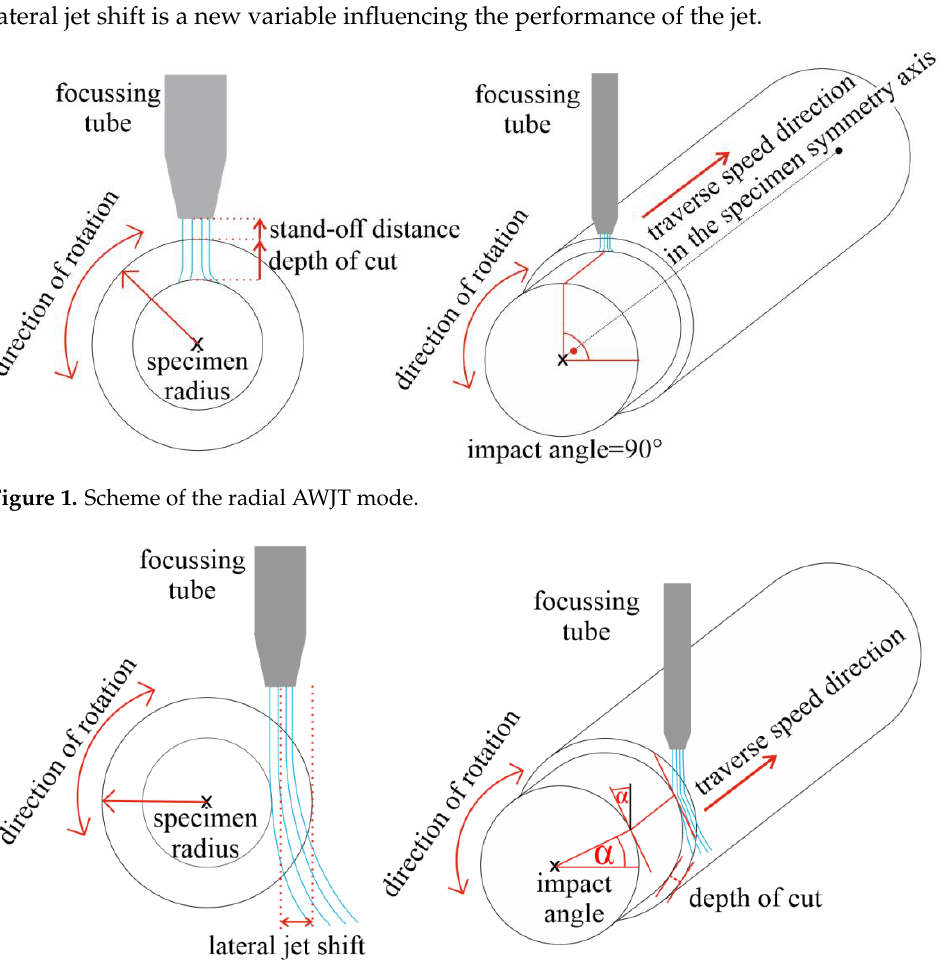
Figure 2. Scheme of the tangential AWJT mode.